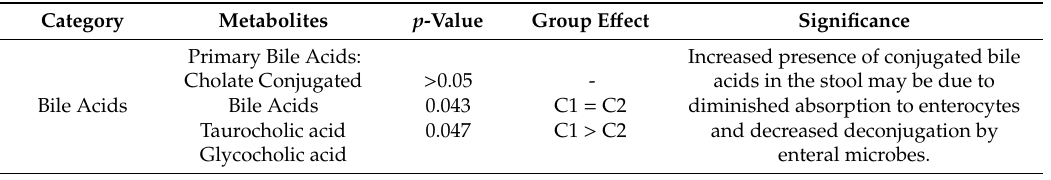
Table 2. Classification, summary, and interpretation of select fecal metabolites.